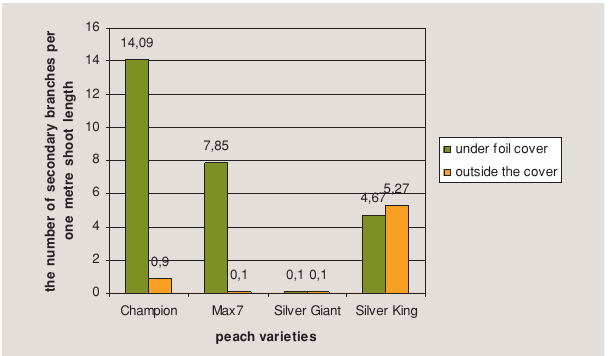
Figure 6. The specified number of secondary branches on 8 year old peach